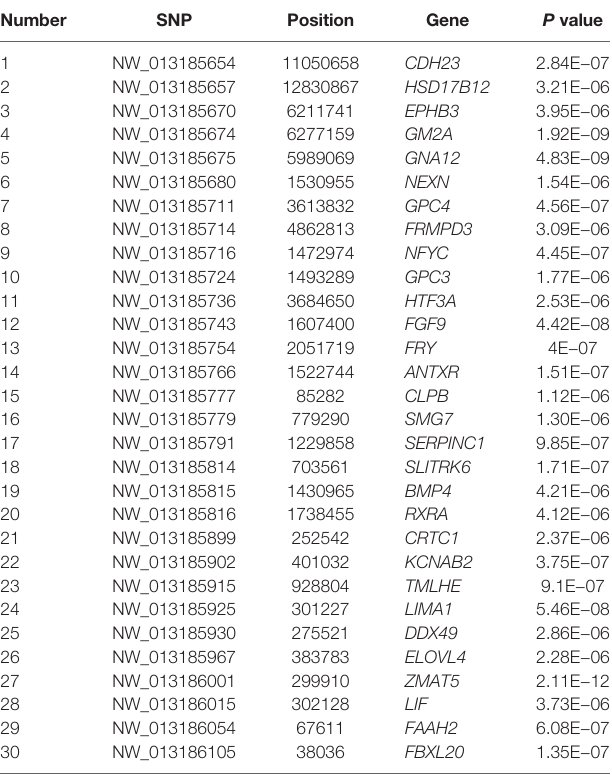
TABLE 3 | The SNPs related to egg laying trait was detected by GWAS.